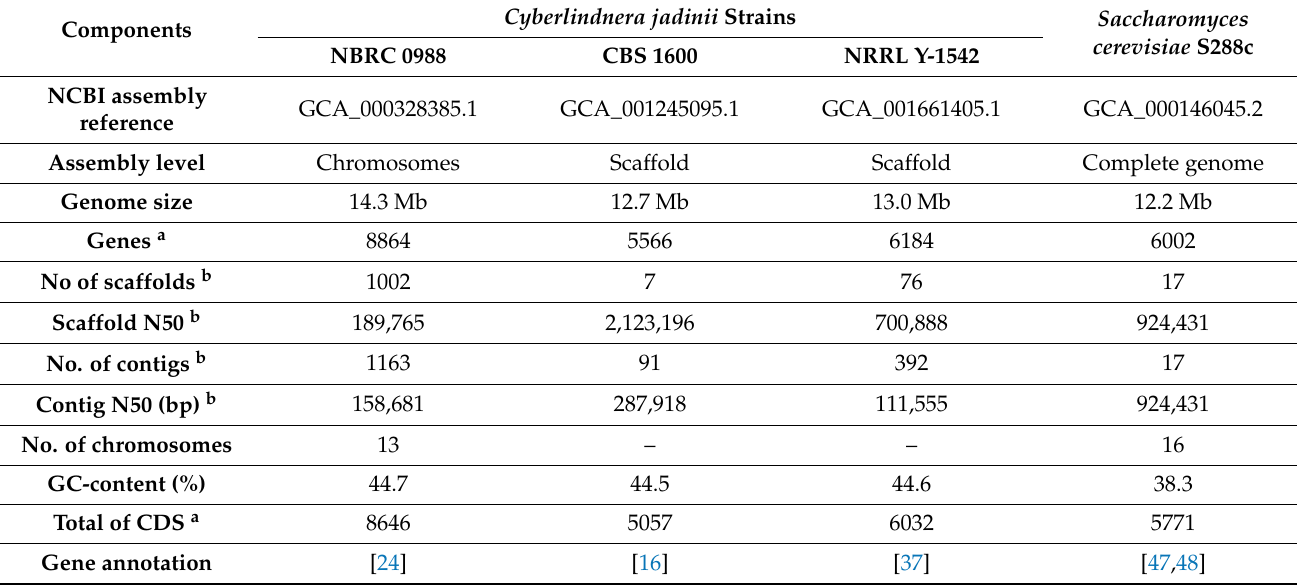
Table 2. Genomic features of three C. jadinii strains and the reference S. cerevisiae strain